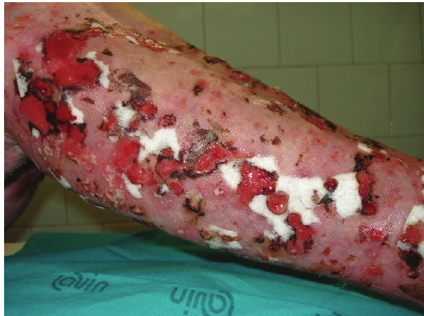
Figure 2: Pustules gradually involving in esulcerative lesions, characterized by a progressive external expansion, unru ffl ed limits and violaceus borders.